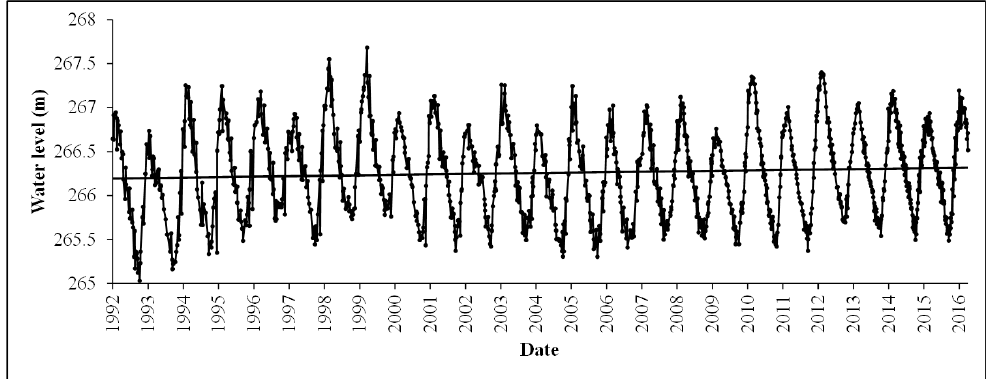
Figure 9. Variations of water levels retrieved from the combination of Hydroweb, GRLM/OSTM and DAHITI.